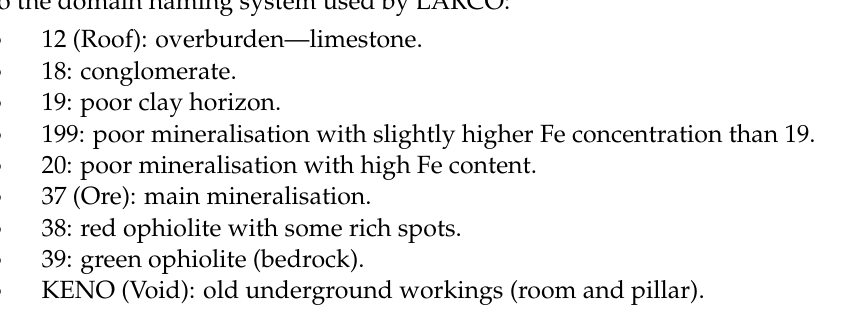
Figure 2. Drillholes from the Tsouka deposit coloured by domains with a 100 × 100 m grid overlay. The following domains were identified and modelled in the Tsouka deposit